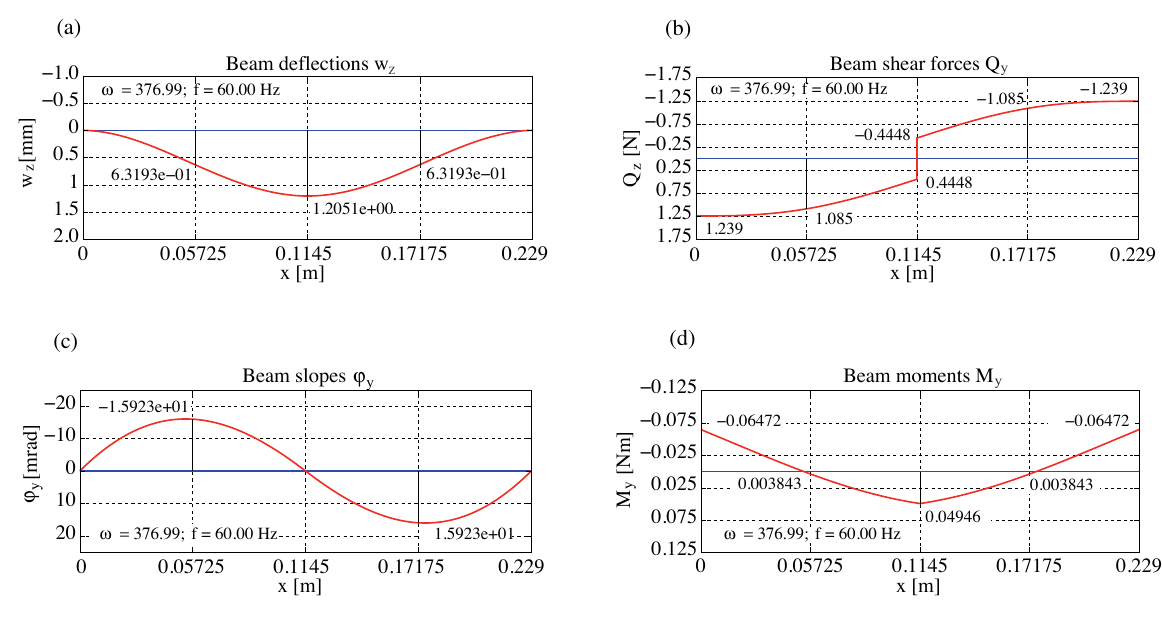
Fig. 13. Amplitudes of displacements and forces at 60 Hz frequency.